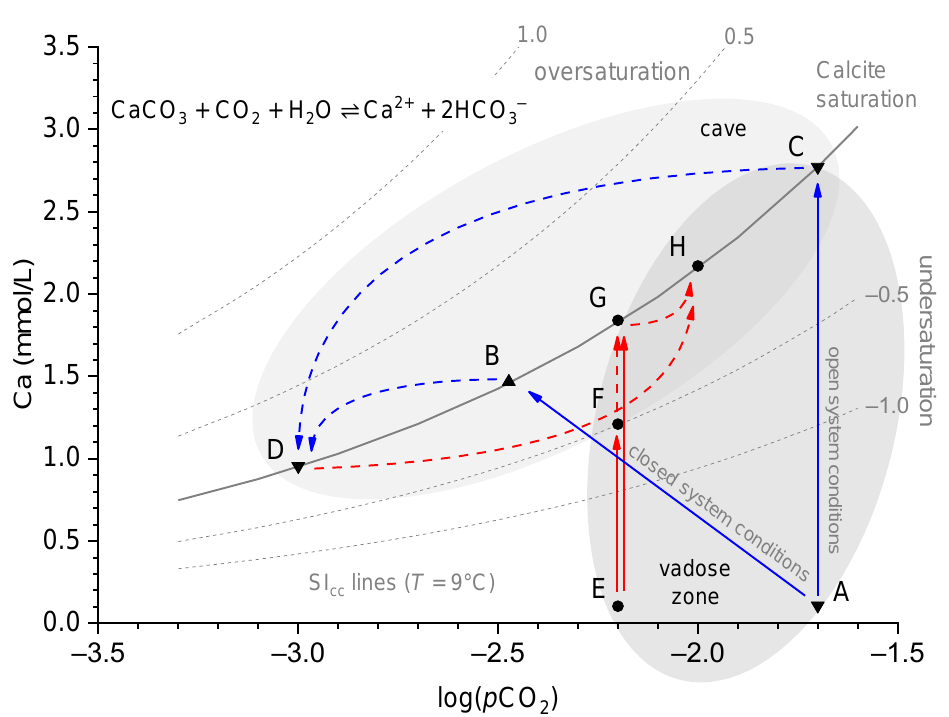
Figure 1. A simplified conceptual model of chemical water evolution in the karst system, showing the dominant processes of CO 2 absorption or degassing and calcite dissolution or precipitation. The solid lines show the processes taking place in the vadose zone, while the dashed lines represent the processes in a cave. Pathways that result in calcite precipitation are shown in blue, while those that cause dissolution are red. The regions with expected Ca concentrations and log( p CO 2 ) values for the soil or cave water are shown by grey ellipses. However, the exact position of a particular solution within the pathway is arbitrary but roughly corresponds to the conditions found in this study. The grey lines with constant saturation indices were calculated in the speciation software PHREEQC for T = 9 °C [31]. The precipitation pathways (solid blue lines) start from a high CO 2 environment at point A ( p CO 2 = 10 −1.7 , ~20,000 ppm). Dissolution of the host rock can follow either a closed system A to B or an open system A to C to reach calcite saturation. Dripwater B or C enters the cave and degasses, causing supersaturation with respect to calcite and calcite precipitates towards D (blue dashed lines), which is in equilibrium with the current p CO 2 of the cave air. The dissolution pathways (solid red lines) show water entering the cave either undersaturated with respect to calcite due to incomplete dissolution of the host rock (E to F), allowing calcite dissolution in the cave (F to G), or saturated with calcite that then absorbs CO 2 from the cave air (D to H or G to H), permitting the dissolution of cave carbonates.